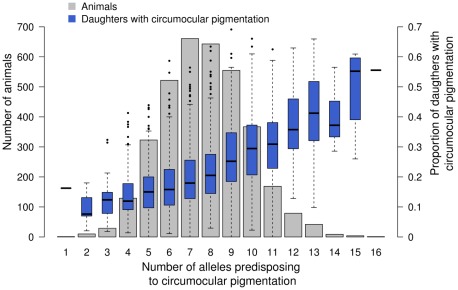
The effect of 14 significantly associated SNPs on the proportion of daughters with ambilateral circumocular pigmentation.3579 Fleckvieh animals are grouped according to the number of alleles that predispose to ambilateral circumocular pigmentation (ACOP). The blue boxplots represent the proportion of daughters with ACOP for each group. The grey bars indicate the number of sires with an increasing number of predisposing alleles.